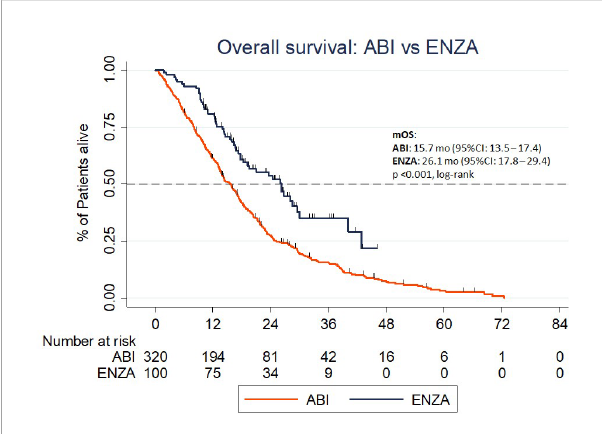
FIGURE 2 The overall survival in the Abiraterone acetate and Enzalutamide